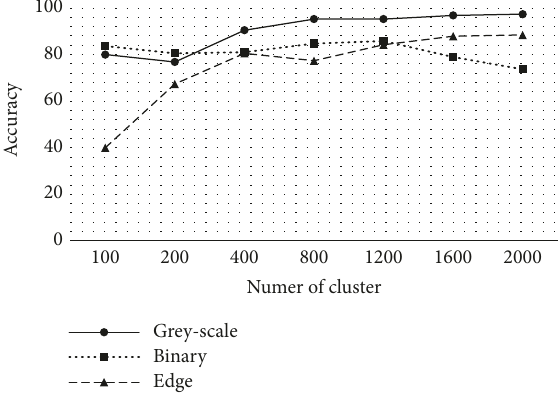
Figure 13: Overall accuracy comparison among different images.